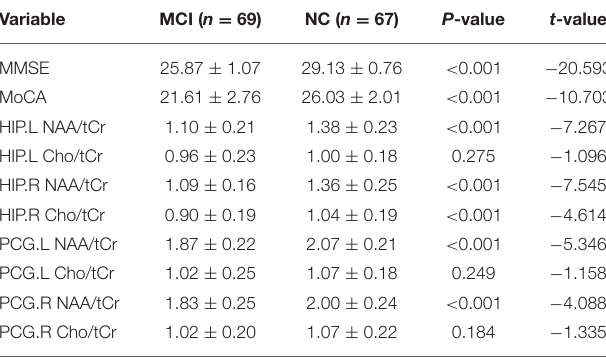
TABLE 2 | MRS test results and cognitive scale scores by diagnostic group ( N = 136). Variable